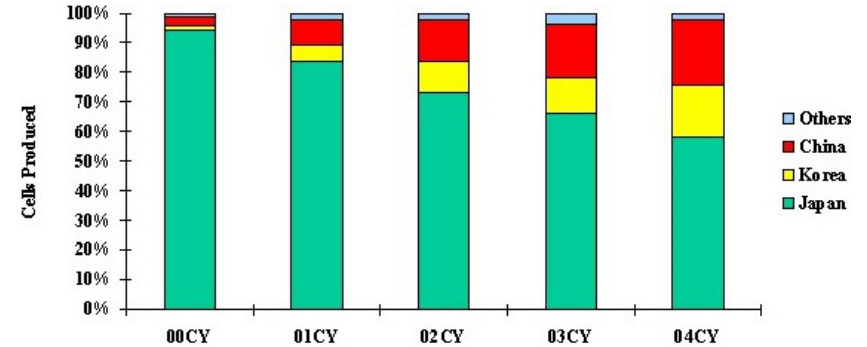
Figure 2. Productions of rechargeable batteries in the countries [16].